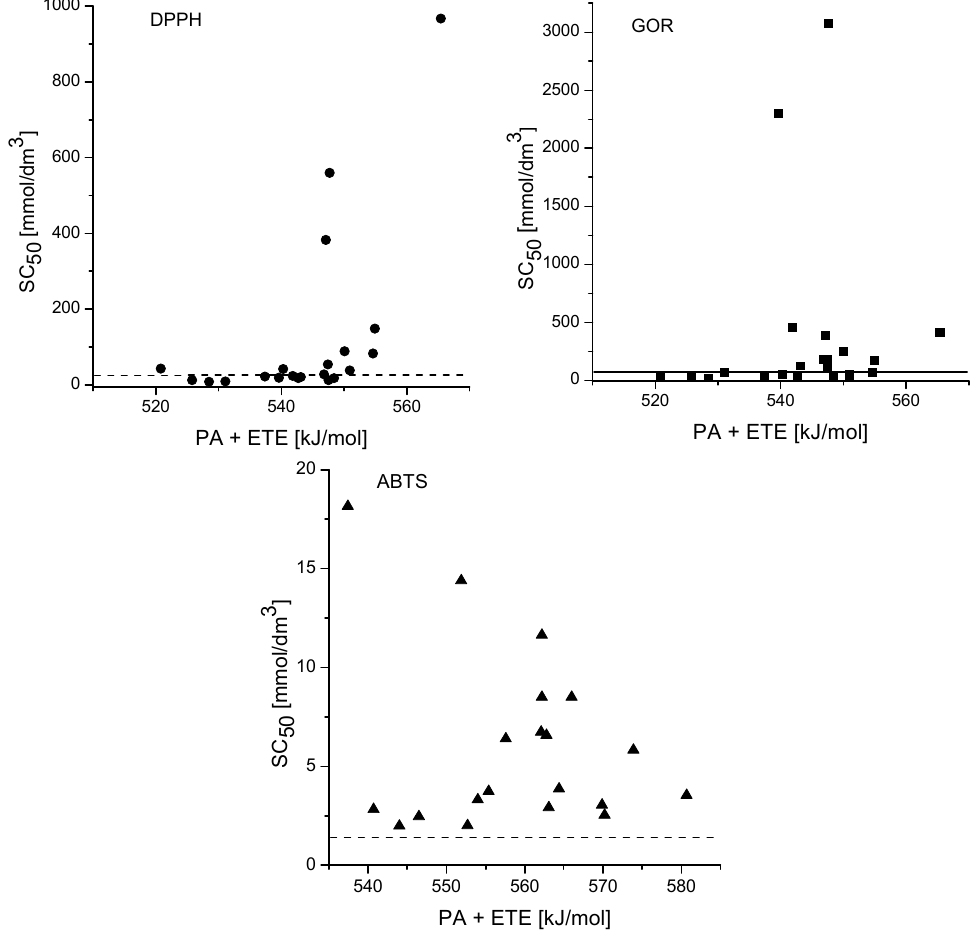
Figure 2. Dependence of SC 50 of DPPH, GOR and ABTS scavenging by studied (Hydroxyphenyliminomethyl)phenols on PA + ETE entalpies. Dashed lines denote the SC 50 values of resveratrol.